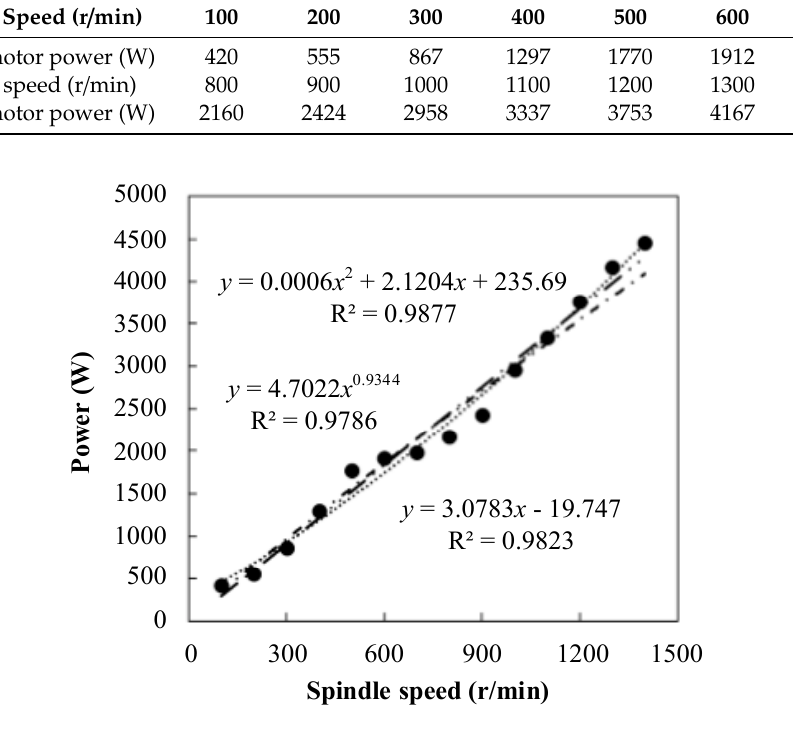
Figure 5. Power measurements of spindle motor.